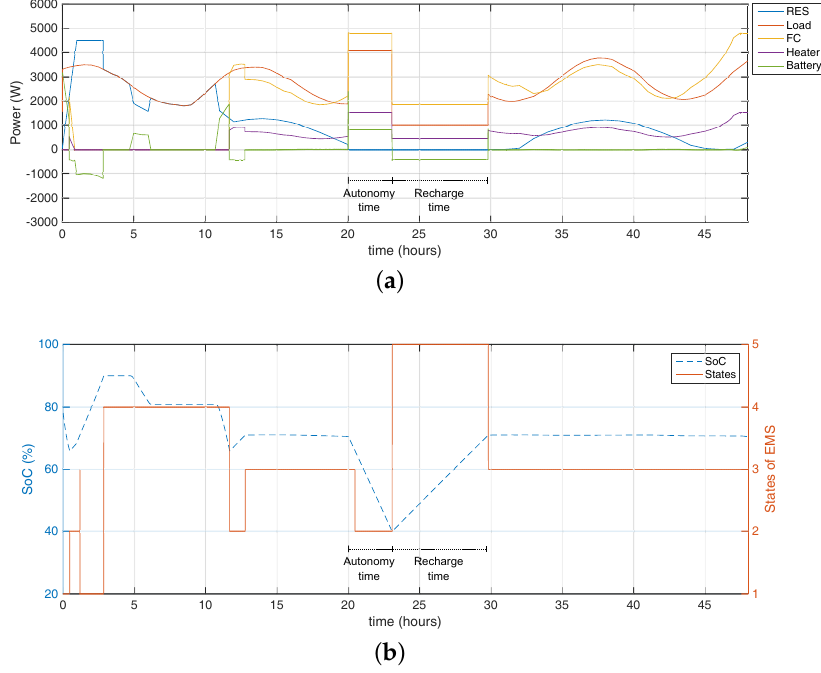
Figure 6. Critical scenario simulation: ( a ) HRES power distribution; ( b ) (dashed line) state of charge of the batteries ( SoC ); (solid line) state transitions in the